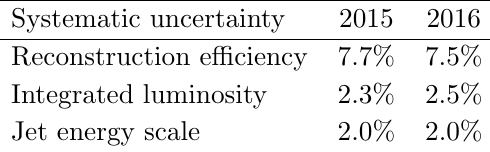
Table 5 . Systematic uncertainties in the signal e(cid:14)ciency in the 2015 and 2016 calorimeter